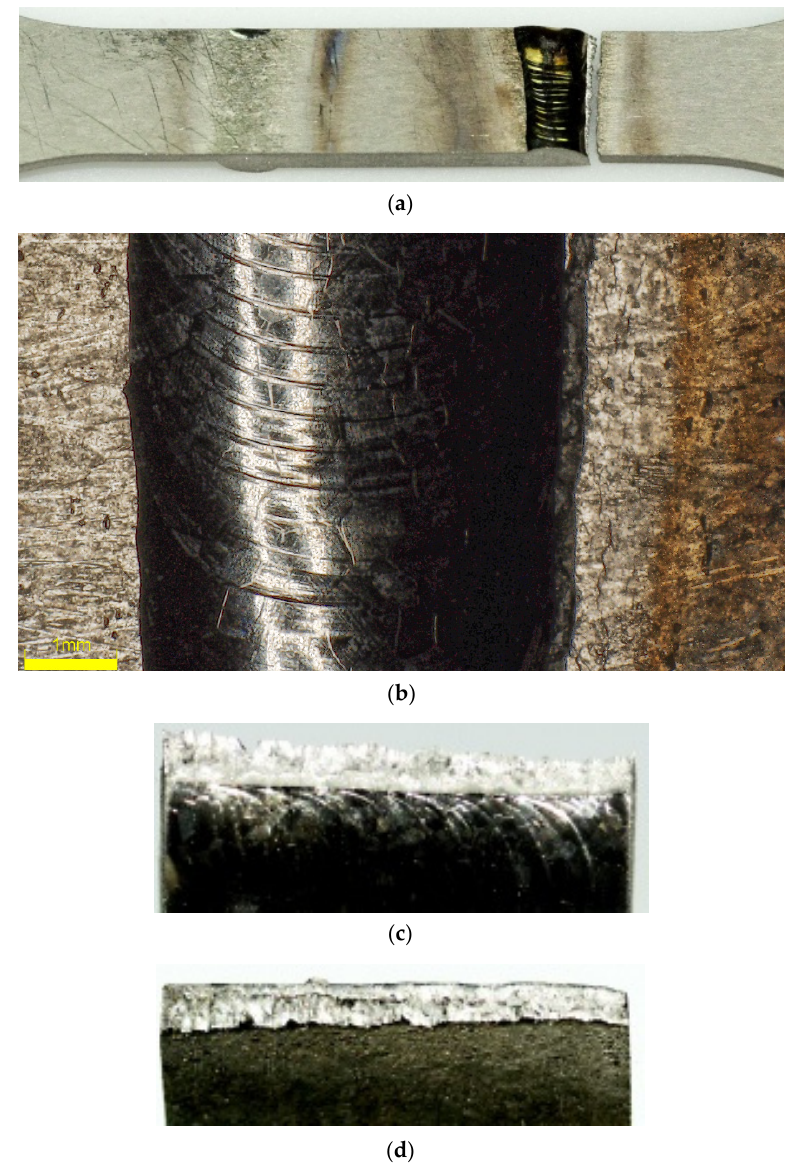
Figure 13. Image of Type 3 specimen ( a ), its weld bead ( b ), after fatigue failure and its fracture surfaces Figure 13. ImageofType3specimen( a ), itsweldbead( b ), afterfatiguefailureanditsfracturesurfaces( c , d ( c , d ).